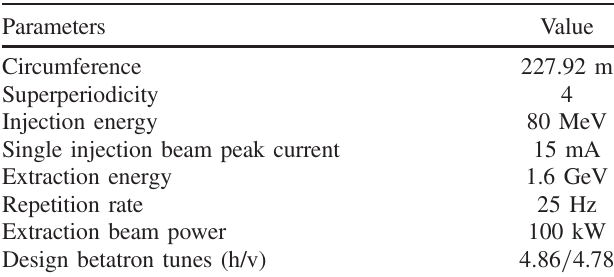
TABLE I. RCS design parameters.